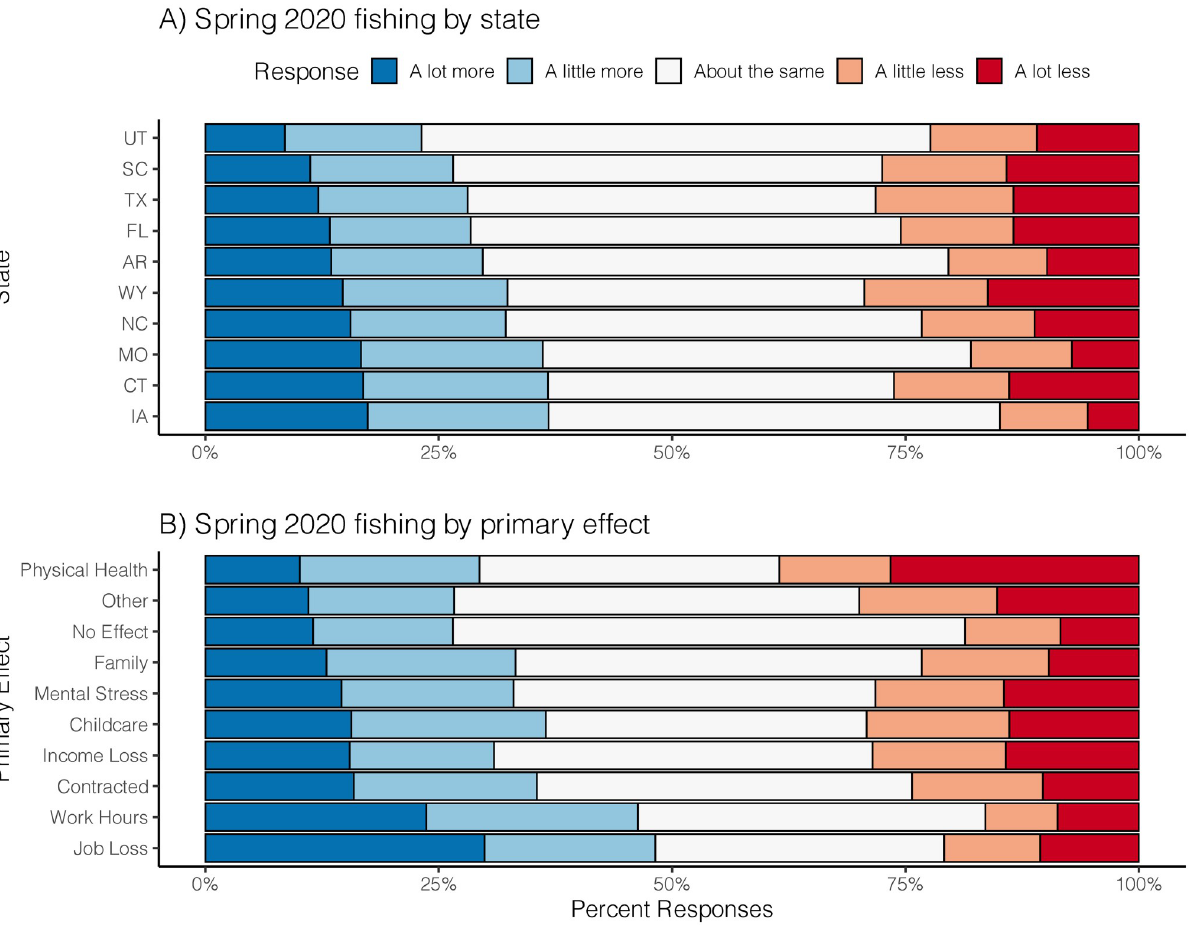
Fig 4. Breakdown of self-reported fishing in spring 2020 (during pandemic) compared to a typical spring. Note that the data are the same responses, but grouped by state in panel A and grouped by primary pandemic effect panel B.